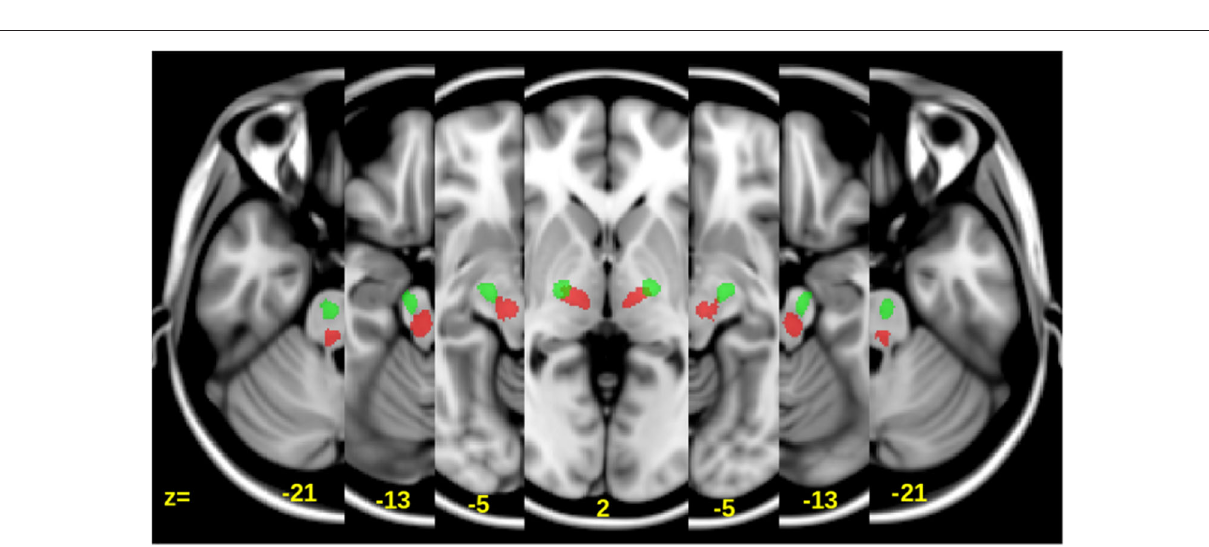
FIGURE 2 | Axial slices showing the location of the CST (Green) and alternate motor fibers (aMF) (Red) overlaid onto a T1 template . The z -coordinates are in Tailarach